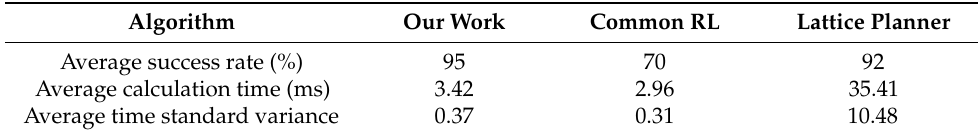
Table 1. Statistics of obstacle avoidance performance parameters of three methods under random difficulty